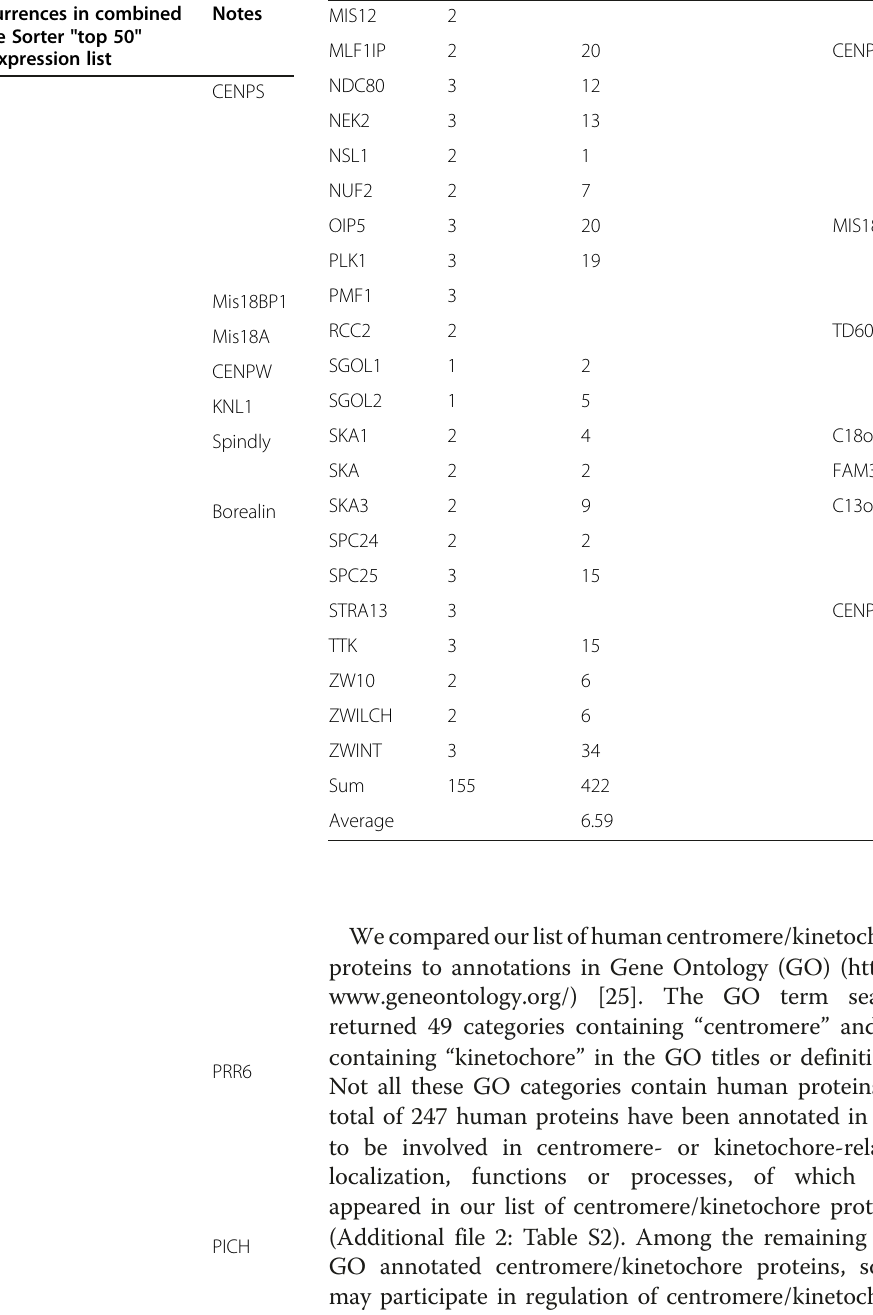
Table 1 The 64 core centromere-kinetochore